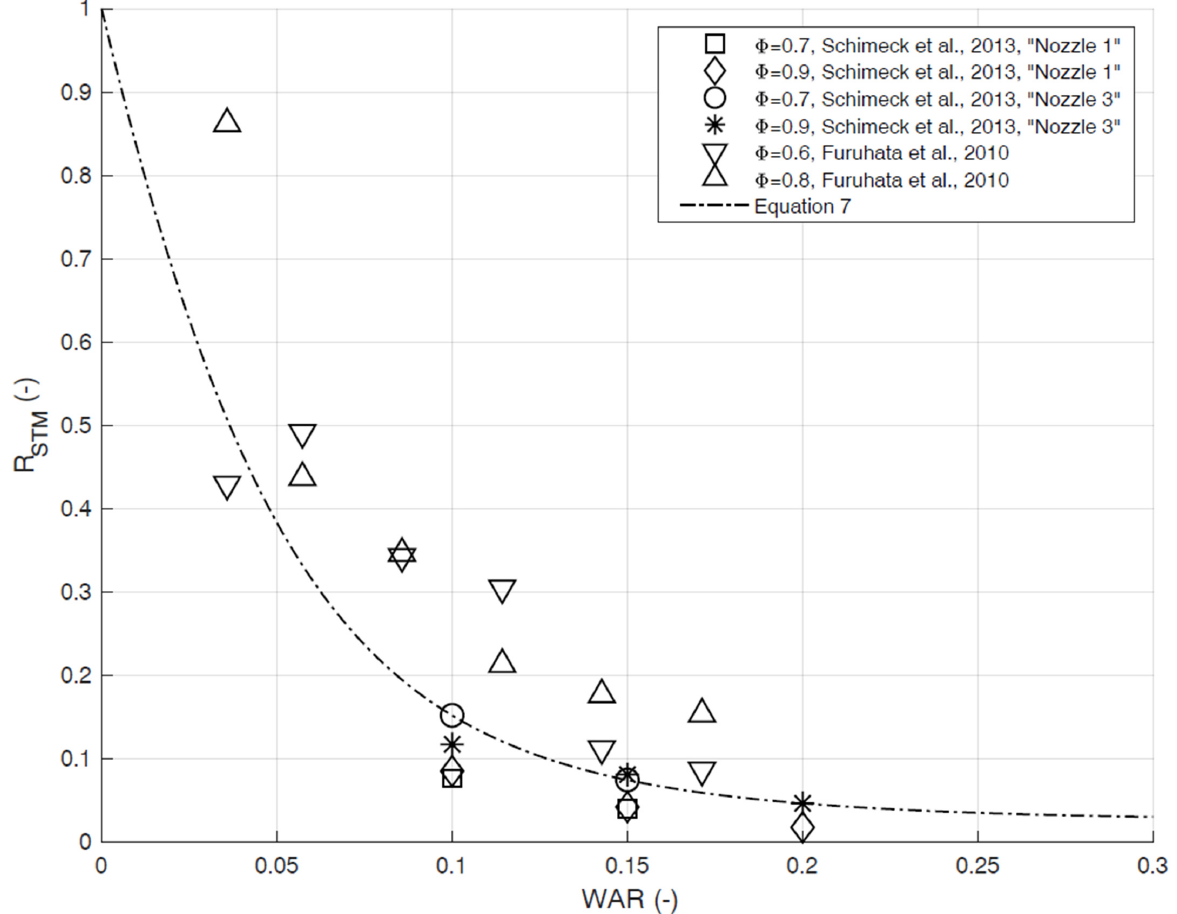
Figure 6. Relative NO x emissions R STM (dry volumetric ppm) between dry and wet operations at constant eqivalence ratio from published experimental data [45,46]. Premixed steam and air with constant inlet temperature T 37 for each data set and atmospheric pressure. The proposed term in Equation (7), based on the available experimental data of [45], is shown with a dashed–dotted line. “Nozzle 1” and “Nozzle 3” refer to the nozzle types as published in [45]. Note that the experimental data are based on volumetric ratios, and it is assumed that the derived term can be applied as a gravimetric ratio in Equation (6), due to nearly constant molar mass ratios of NO x and the combustion gases.